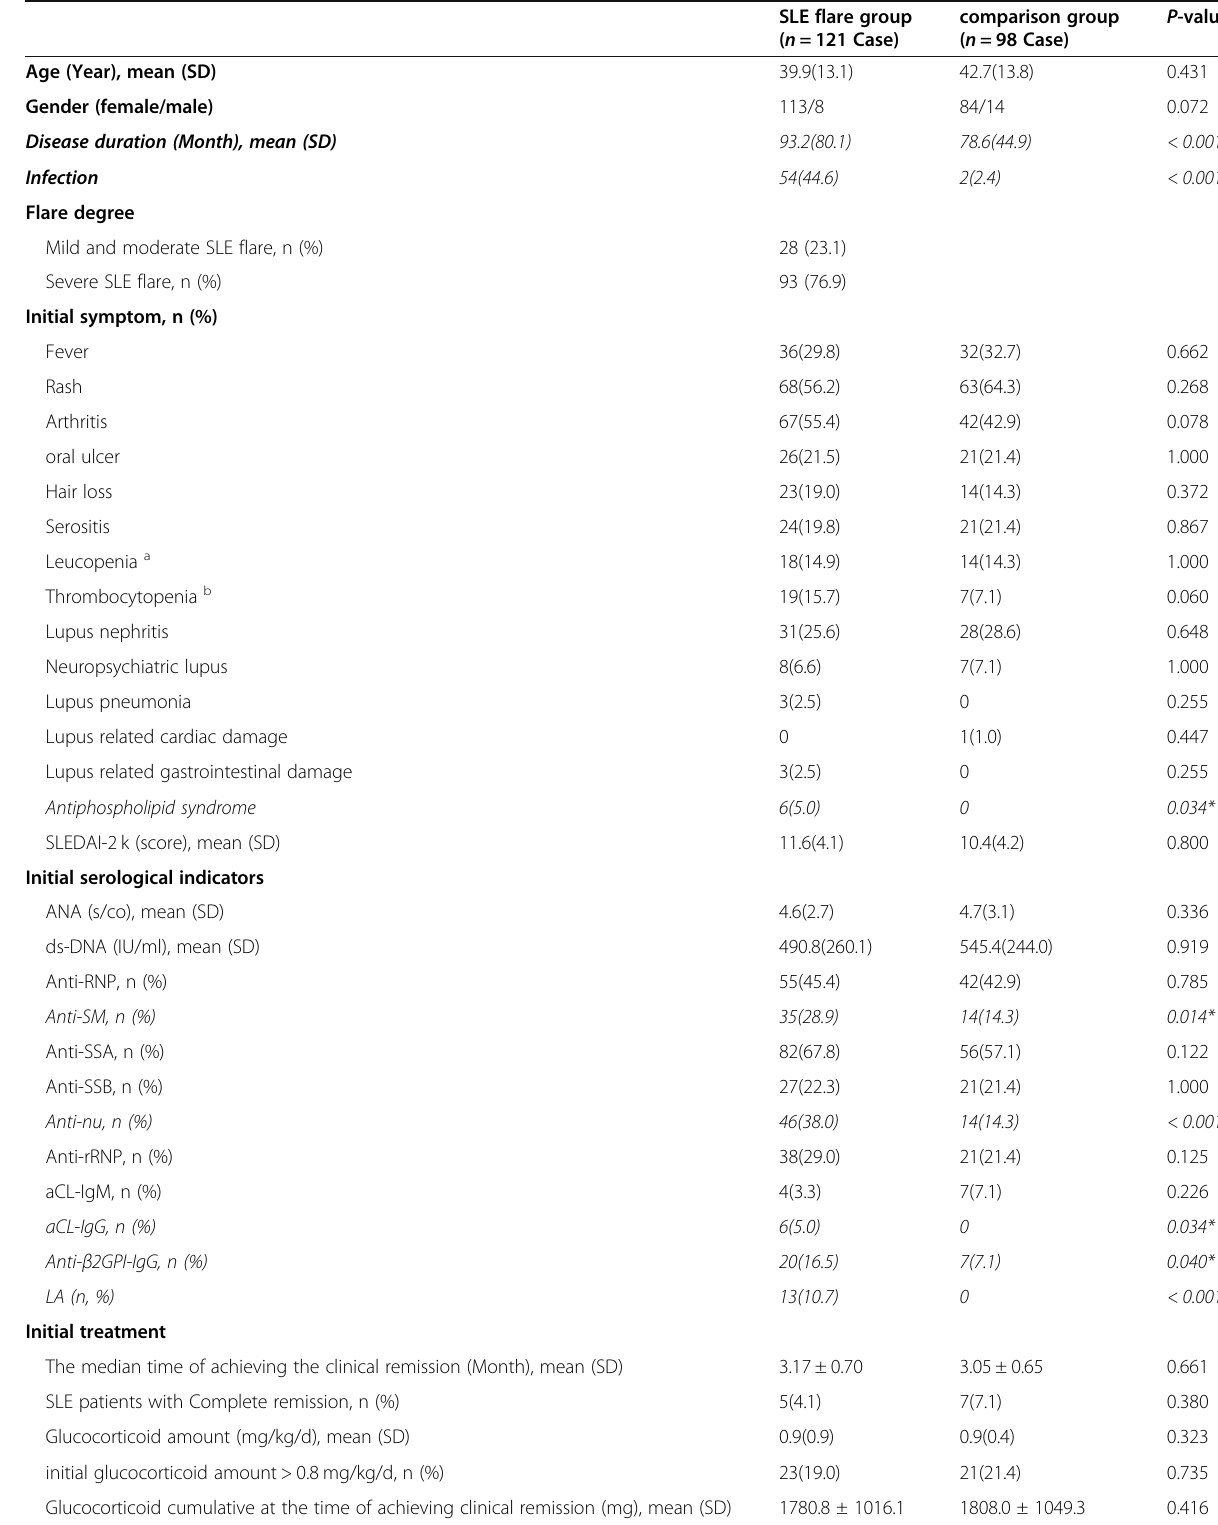
Table 1 Clinical characteristics and treatment in patients with SLE flare or sustained remission of